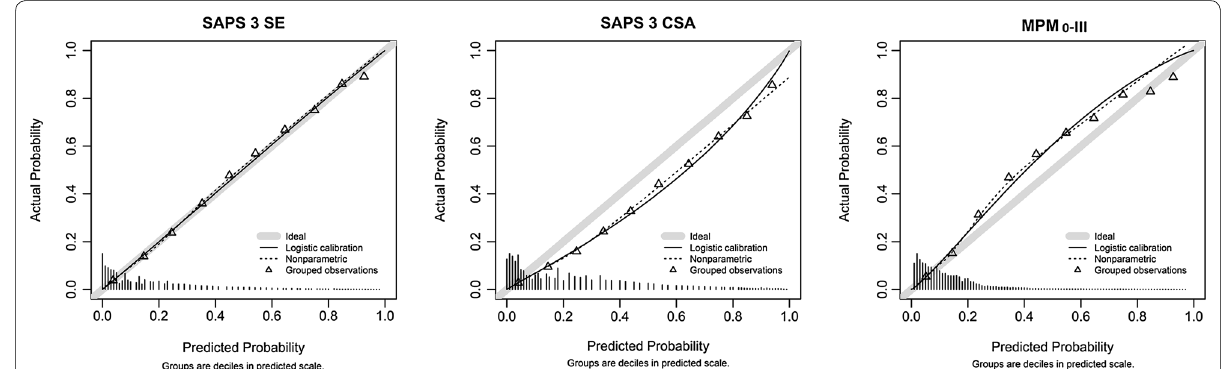
Fig. 2 Calibration plots for SAPS 3-SE, SAPS 3-CSA and MPM 0 -III, with predicted mortality rates stratified by 10% intervals of mortality risk ( x -axis) against observed mortality rates ( y -axis)